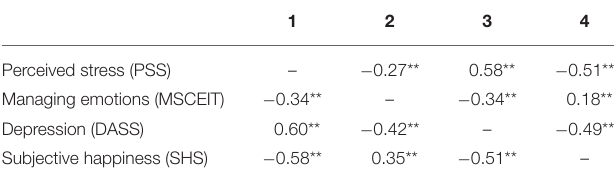
TABLE 2 | Intercorrelations among measures separately for females and